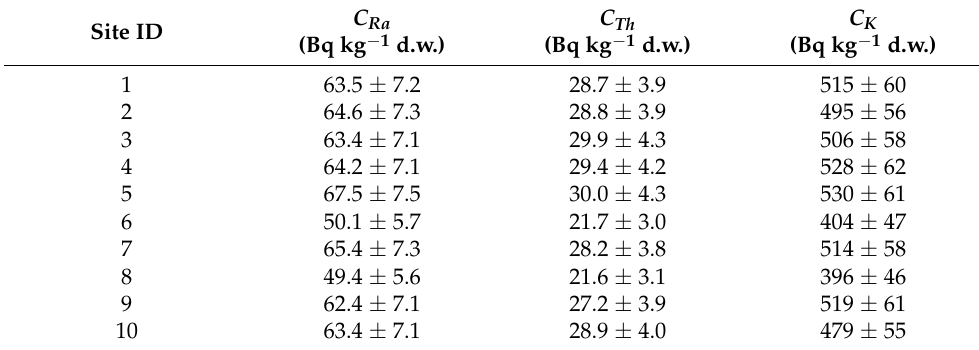
Table 3. The average activity concentrations C Ra , C Th , and C K of, respectively, 226 Ra, 232 Th, and 40 K, in the investigated samples.